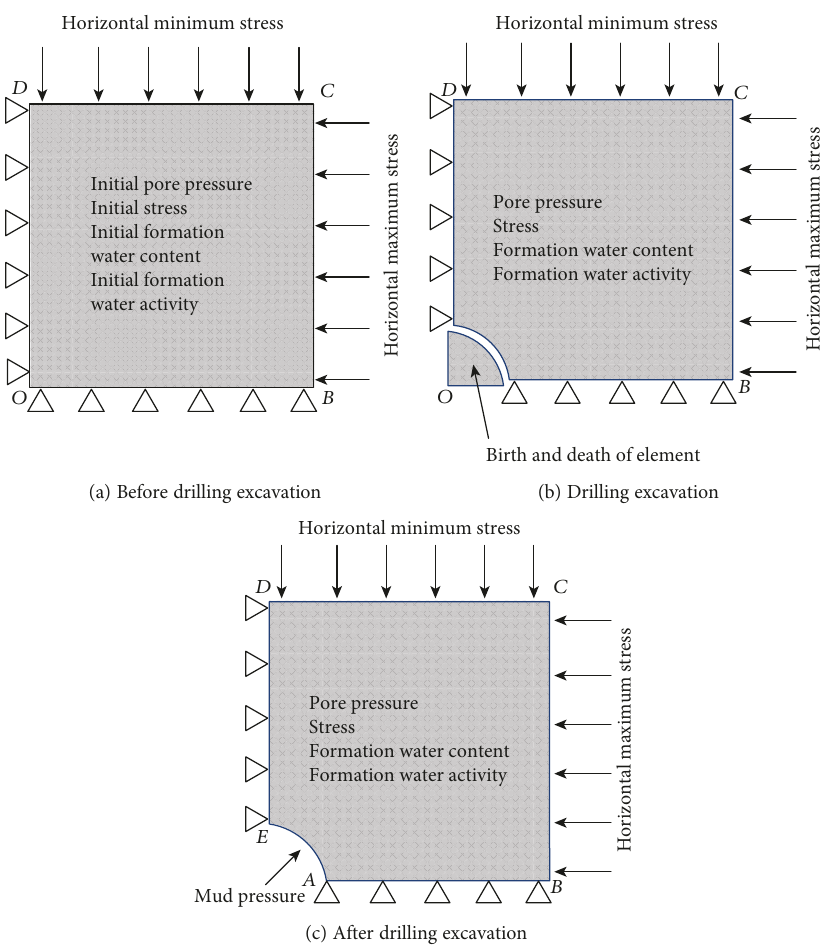
Figure 8: Schematic diagram of the calculation